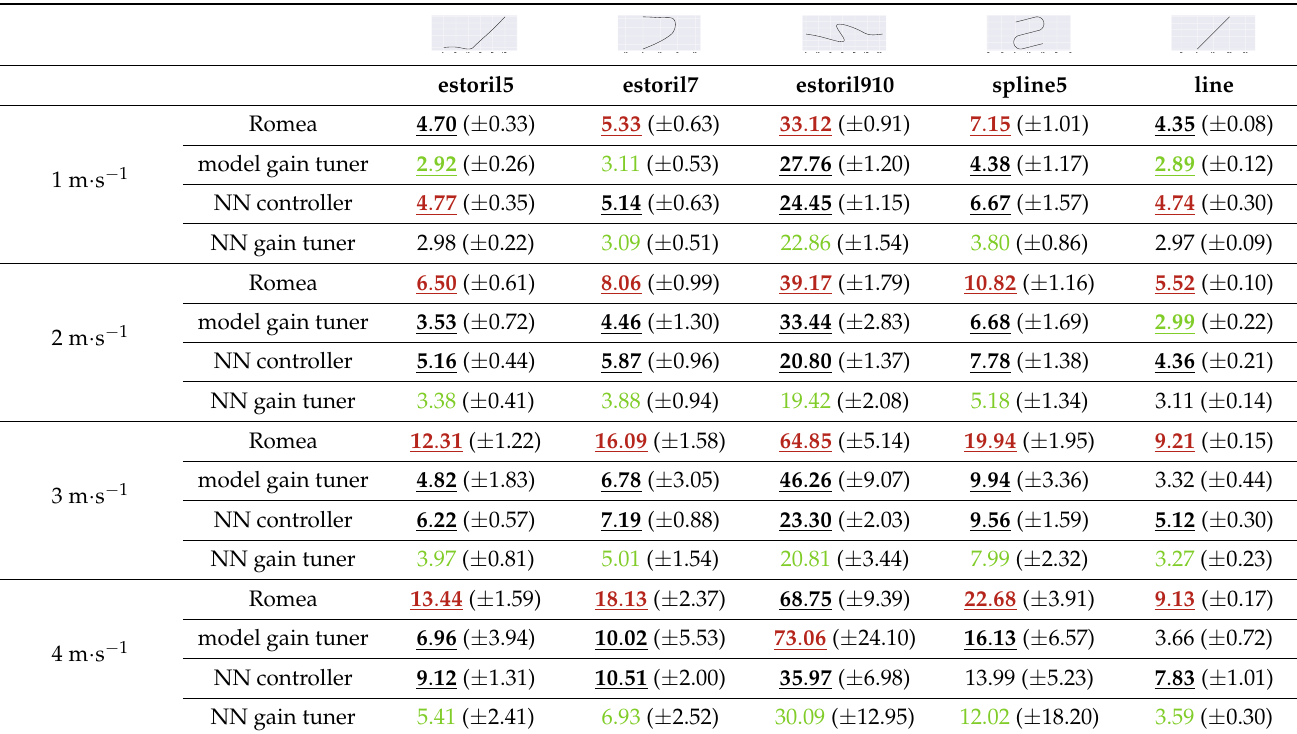
Table 2. Surface error in (m 2 )of each method at all the speeds and trajectories used during training, with an initial error of 1 m. Bold and underlined numbers show that the results are significant, green shows the best result, and red show the worst result.